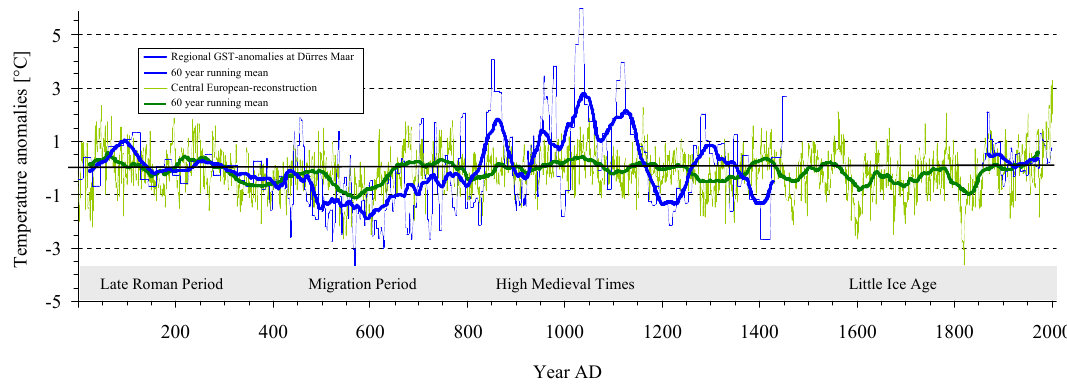
Fig. 6. The estimated growing season temperature (GST) anomalies at D¨urres Maar compared to the western European temperature recon- struction of B¨untgen et al. (2011) which is based on multiple standardized tree-ring width series. Both proxy datasets are not scaled to any observational record. The bolt lines show the 60yr running